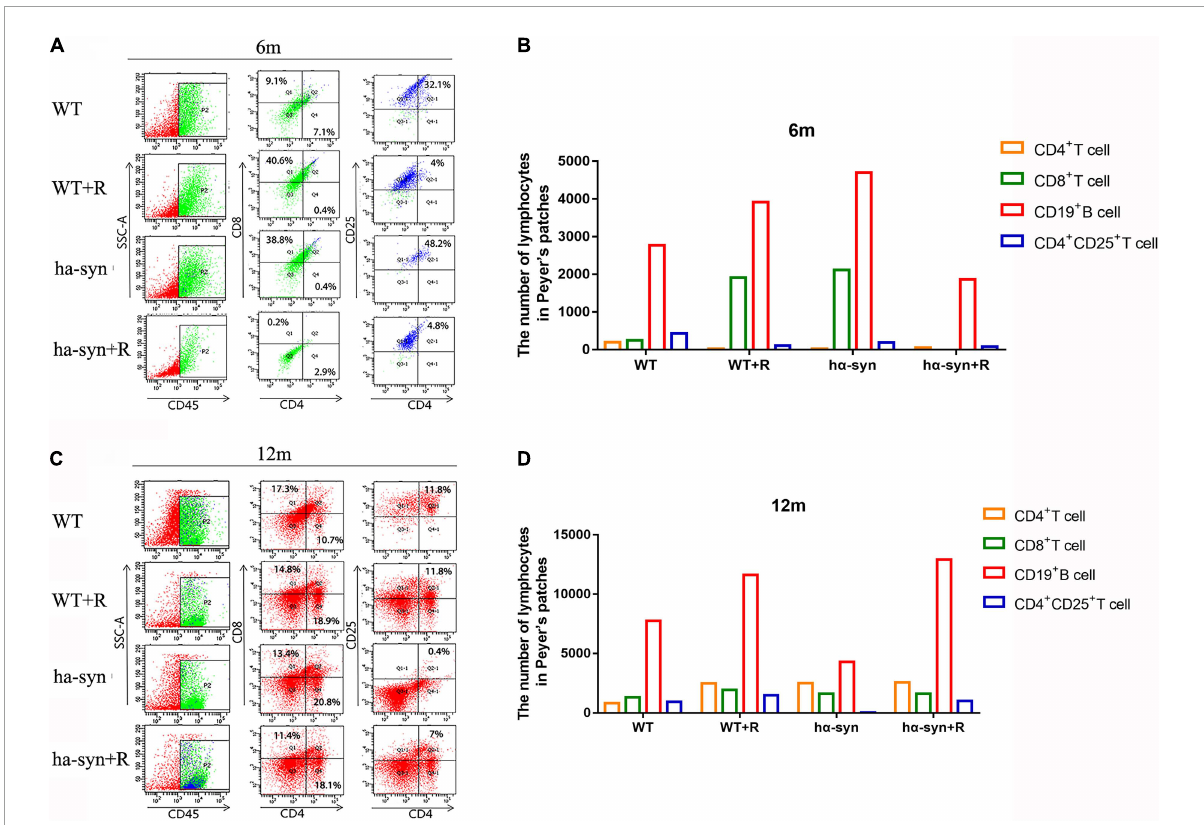
FIGURE6 The effect of rotenone on subpopulations of Peyer’s patches lymphocytes in h α -syn + / − mice. Flow cytometry was used to detect the changes in lymphocyte subsets, namely, CD4 + , CD8 + , and CD4 + CD25 + lymphocytes, respectively, in Peyer’s patches in mice of different ages. (A) Changes of lymphocyte subsets in Peyer’s patches of 6-month-old h α -syn + / − mice by flow cytometry, n = 6. (B) Statistics of the number of cells in Peyer’s patches of 6-month-old h α -syn + / − mice. (C) Changes of lymphocyte subsets in Peyer’s patches of 12-month-old h α -syn + / − mice by flow cytometry, n = 6. (D) Statistics of the number of cells in Peyer’s patches of 12-month-old h α -syn + / −